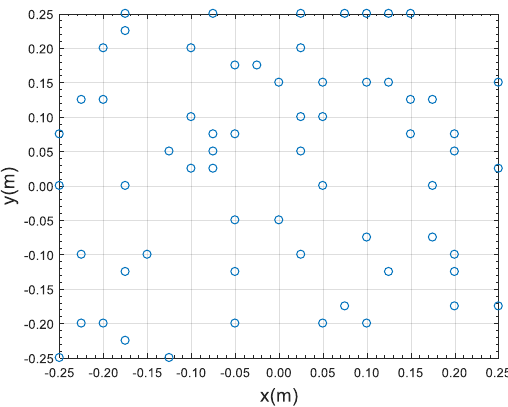
Figure 2. The array with 64 randomly distributed microphones.